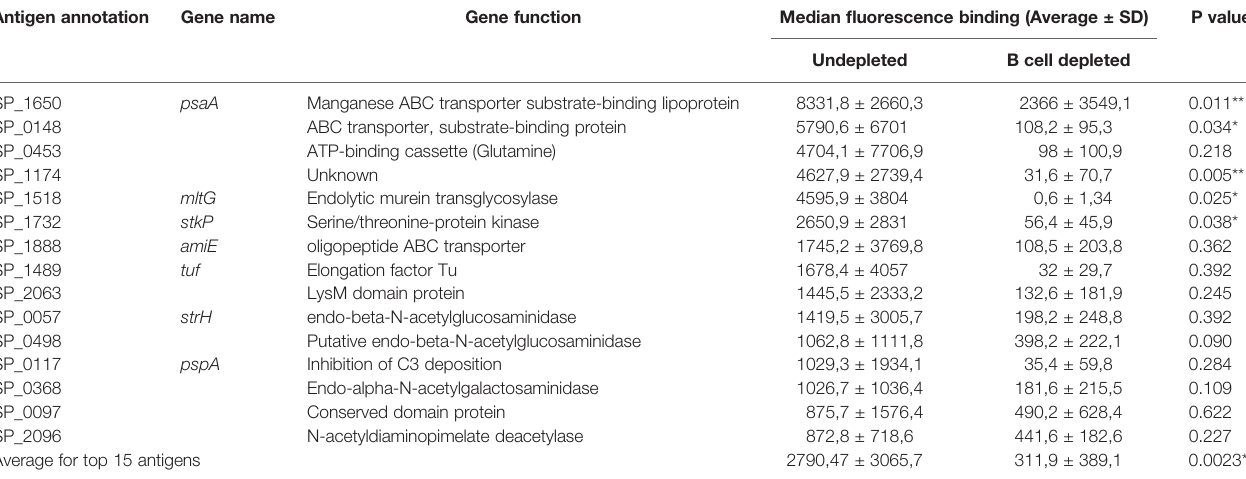
TABLE 1 | IgG levels against pneumococcal antigens measured by protein array. Antigen annotation